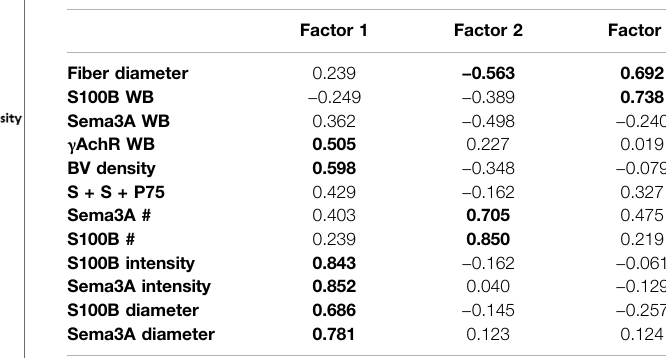
TABLE 2 | Loading correlations of variables onto 3 factors identi fi ed by principal component analysis of the full dataset of muscles ( n = 26) regenerating from injury with or without pretreatment by ISDN before injury. WB indicates protein assays by Western blotting, BV = blood vessel, “ S + S + P75 ” indicates the number of regions in which P75 protein (by immunostaining) was colocalized with both S100B and Sema3A transcripts (by in situ hybridization, ISH). # indicates the number of expression sites by ISH. Loading coef fi cients greater than 0.5 (in bold type) were considered strong